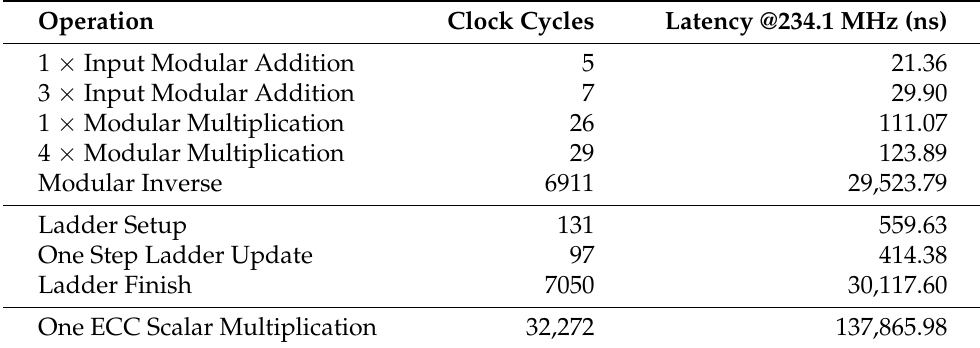
Table 2. Performance analysis of proposed generic ECC processor (256-bit) on